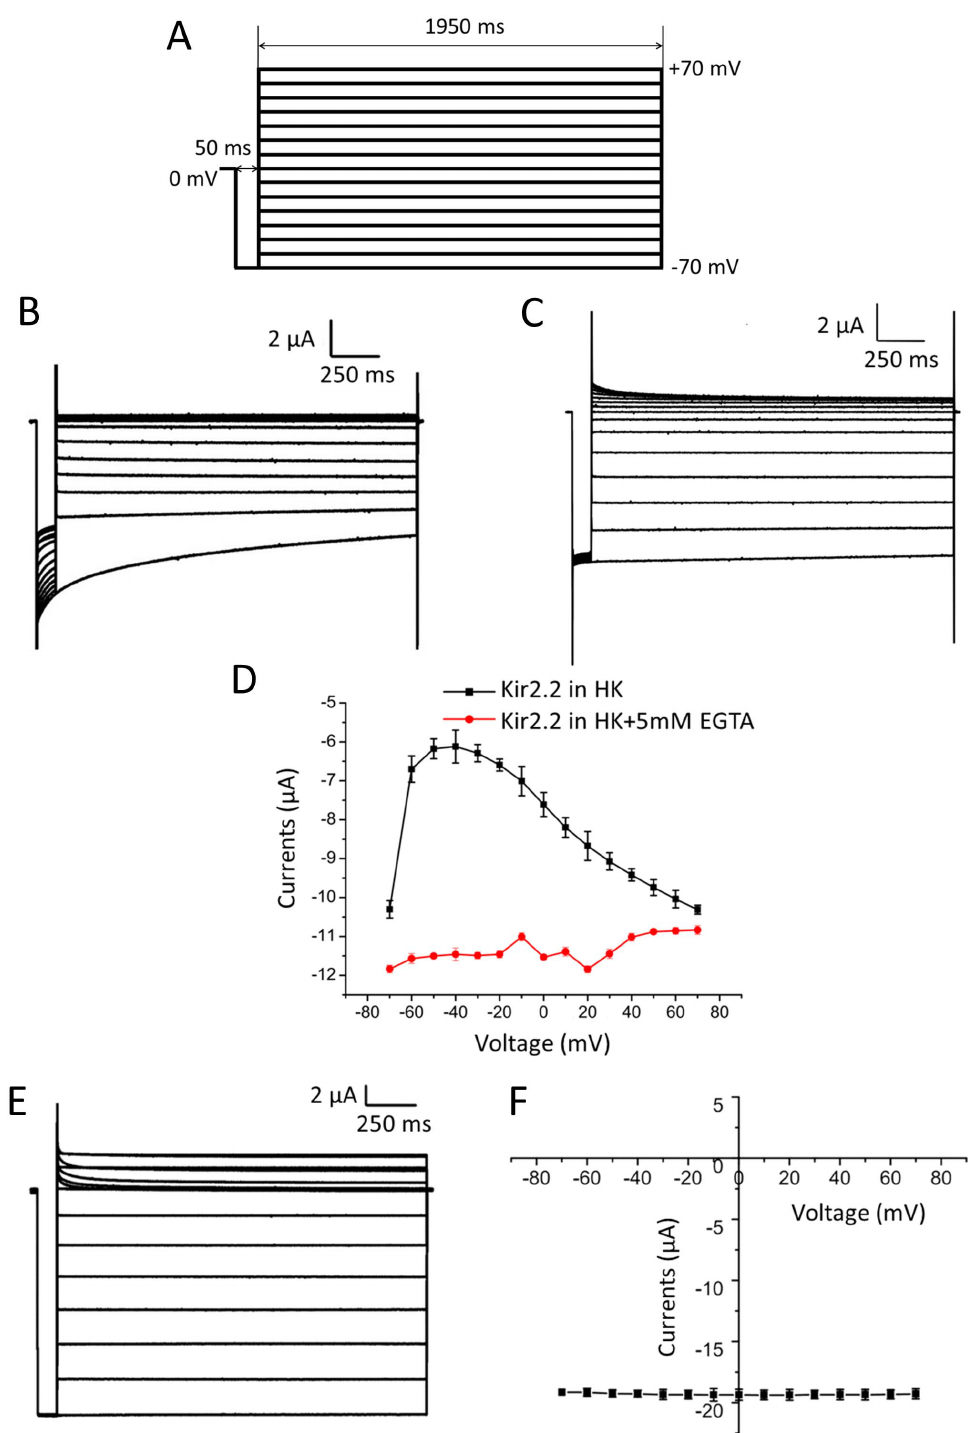
Figure 1. External Mg 2 + voltage-dependently blocks the currents through Kir2.2 but not Kir2.1. Whole-cell currents were recorded by two-electrode voltage clamp. (A) Protocol used for activating the currents. The protocol contains a series of 2s-long sweeps. Each sweep consisted of a 50 ms test pulse to 2 70 mV and 1950 ms conditional pulse from 2 70 mV to + 70 mV in 10 mV steps. There are 15 sweeps for each experiment. The first 50-ms test pulse ( 2 70 mV) is going before the conditional pulses. As a control, the test pulses follow the conditional pulses. (B) and (C) are the representative currents Kir2.2 recorded with and without Mg 2 + . (D) is the relationship between the currents of Kir2.2 recorded at 2 70 mV and the corresponding conditional voltage. The data recorded with 1 mM Mg 2 + and 0 Mg 2 + are shown as black and red lines, respectively. (E) is the representative currents Kir2.1 recorded with Mg 2 + . (F) is the relationship between the currents of Kir2.1 recorded at 2 70 mV and the corresponding conditional voltage. Data represent means 6 SEM for 7 experiments.